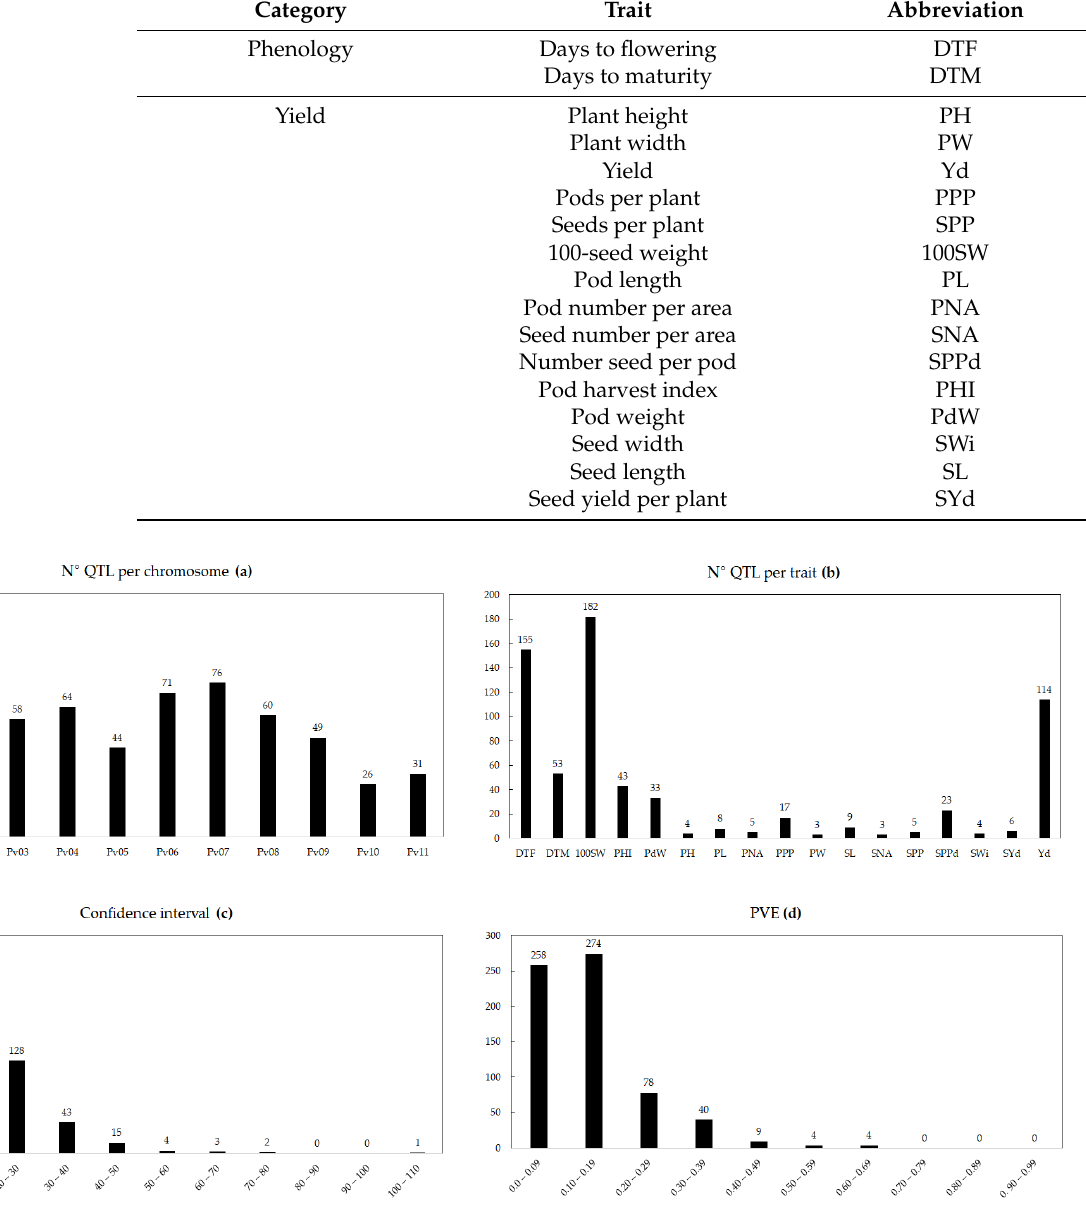
Figure 1. Summary of the 667 collected QTL related to phenological, yield, and yield component in common bean. Number of QTL per chromosome ( a ), number of QTL per trait ( b ), confidence interval ( c ), phenotypic variance explained (PVE) for each QTL ( d ). DTF: Days to flowering; DTM: